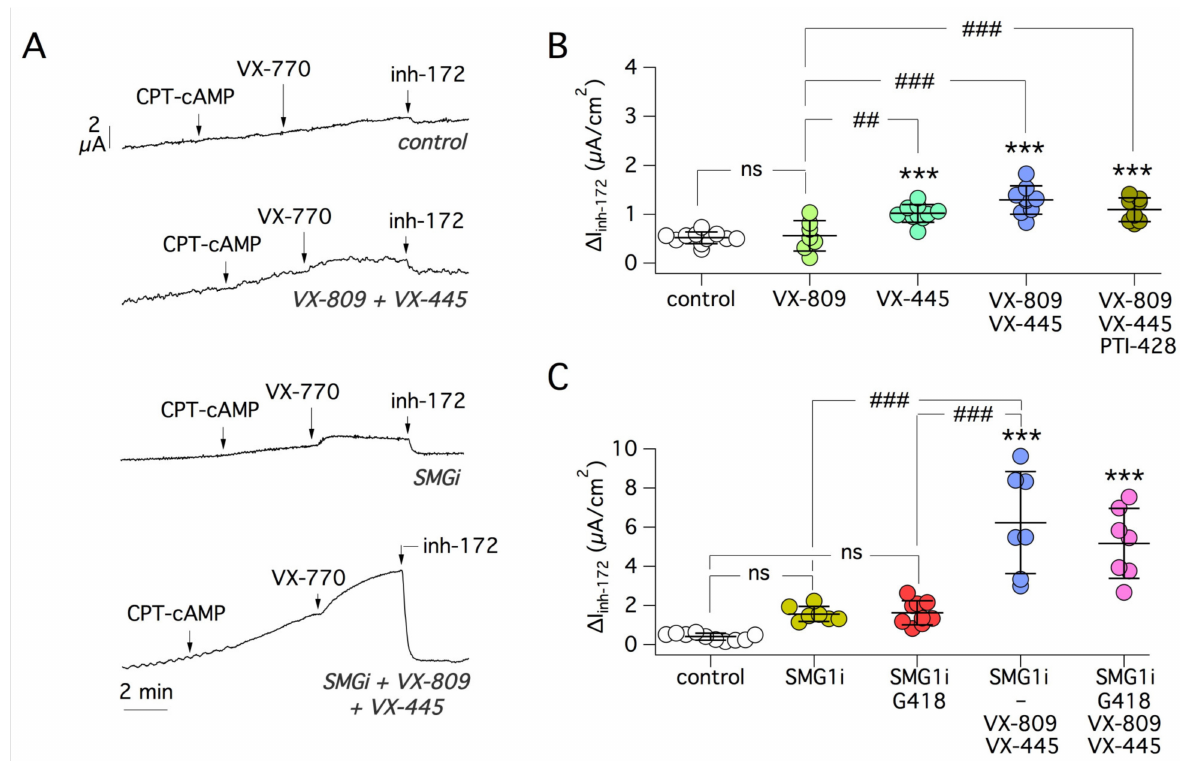
Figure 7. Sensitivity of W1282X-CFTR to correctors and SMG1i. ( A ) Representative short-circuit current traces from 16HBE14o- cells expressing W1282X-CFTR. Cells were treated for 24 h with indicated compounds. ( B ) Scatter dot plot summarizing the results obtained after treatments with CFTR correctors (VX-445, 5 µ m; VX-809, 1 µ M) and PTI-428 (30 µ M). ***, p < 0.001 vs. control. ##, p < 0.01; ###, p < 0.001 vs. VX-809. ( C ) Scatter dot plot summarizing the results obtained with SMG1i (1 µ M) with/without the indicated combinations of compounds (VX-445, 5 µ M; VX-809, 1 µ M; G418, 0.5 mg/mL). ***, p < 0.001 vs. control. ###, p < 0.001 vs. SMG1i or SMG1i plus